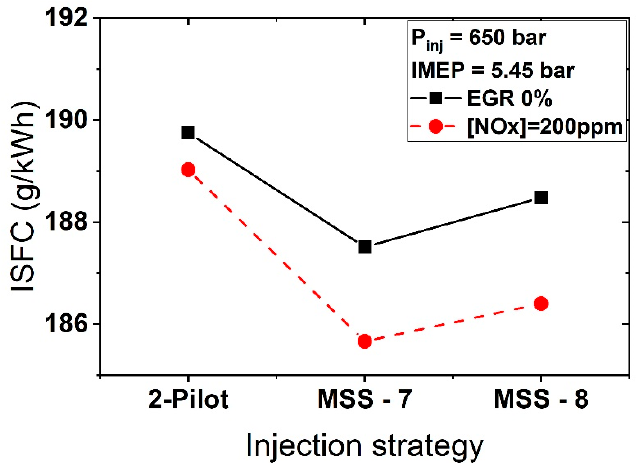
Figure 13. Indicated specific fuel consumption (ISFC) results for the two-pilot injection strategy and the two MSS injection strategies.